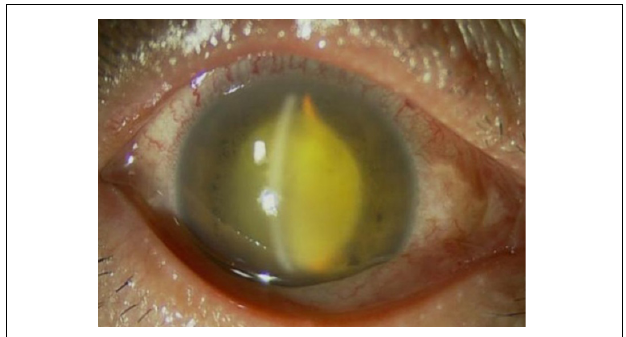
FIGURE 1 | Anterior segment photograph of the right eye shows slight hyperemia of the conjunctiva, transparent cornea, deep anterior chamber, turbid aqueous humor, less round pupil, posterior iris adhesion, opaque lens, obvious vitreous opacity, with fundus invisible.